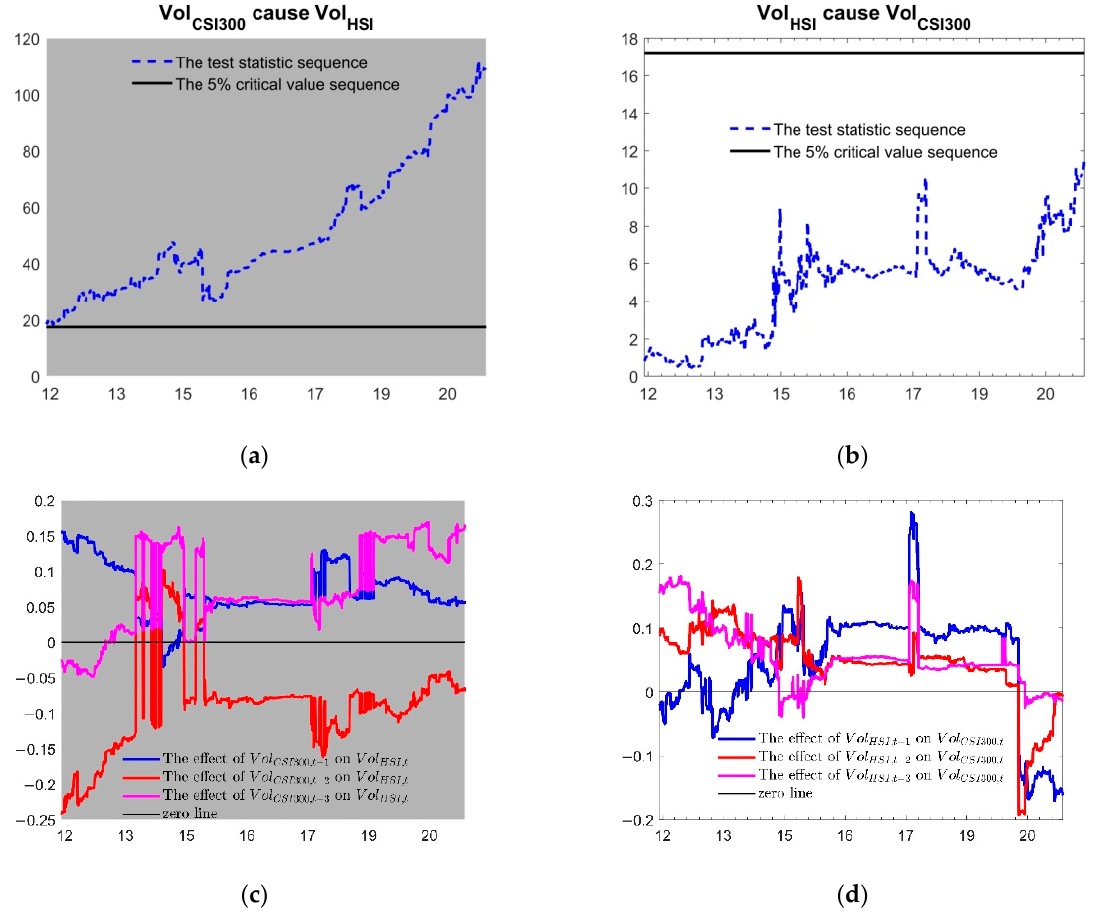
Figure 5. Time varying causalities between CSI 300 and HSI at volatility level. ( a ) Graphical results of whether Vol CSI 300 is a cause of Vol HSI ; ( b ) Graphical results of whether Vol HSI is a cause of Vol CSI 300 ; ( c ) The effect of lag-term Vol CSI 300 on Vol HSI ; ( d ) The effect of lag-term Vol HSI on Vol CSI 300 .